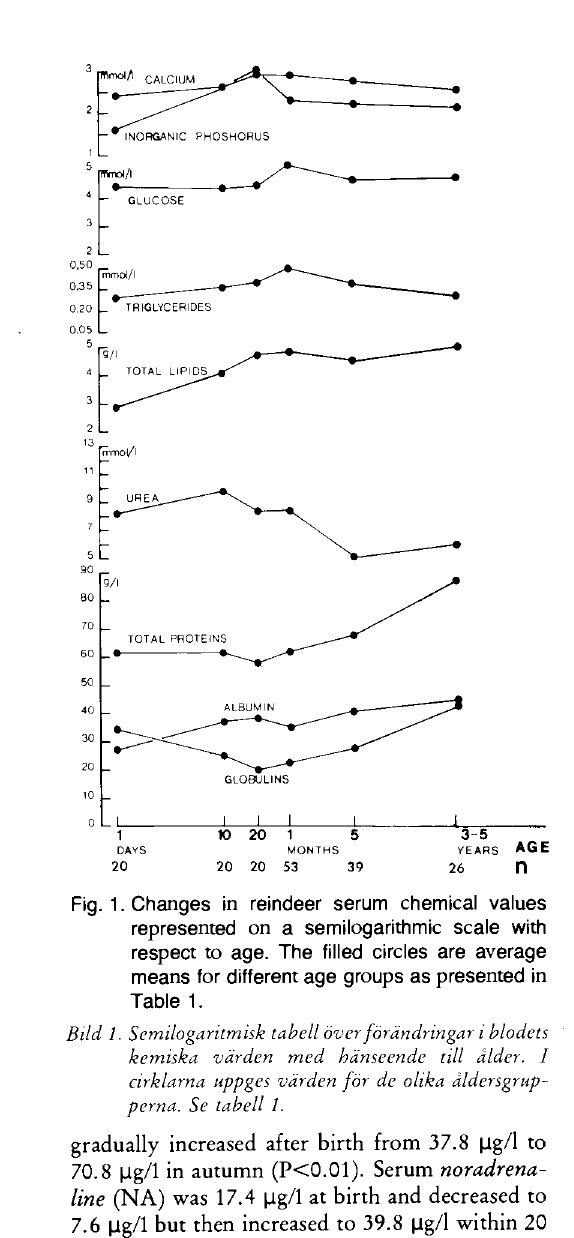
Fig. 1. Changes in reindeer serum chemical values represented on a semilogarithmic scale with respect to age. The filled circles are average means for different age groups as presented in Table 1. Bild 1. Semilogantmisk tabell over fordndringar i blodets kemiska vdrden med hdnseende till alder. I cirklarna uppges vdrden for de olika aldersgrup- perna. Se tabell 1. gradually increased after birth from 37.8 |Jg/l to 70.8 Mg/1 in autumn (P<0.01). Serum noradrena line (NA) was 17.4 [ig/1 at birth and decreased to 7.6 Hg/1 but then increased to 39.8 |Jg/l within 20 days (P<0.001) (Nieminen et al. 1980b). Serum Cortisol level of calves and adult hinds was 145 nmol/1 during autumn and winter. from the newborn value (4.4 mmol/1) during the calfhood summer, and high value were found for 5-month-old calves and adult hinds during autumn (4.69 and 4.58 mmol/1, respectively) (Fig.